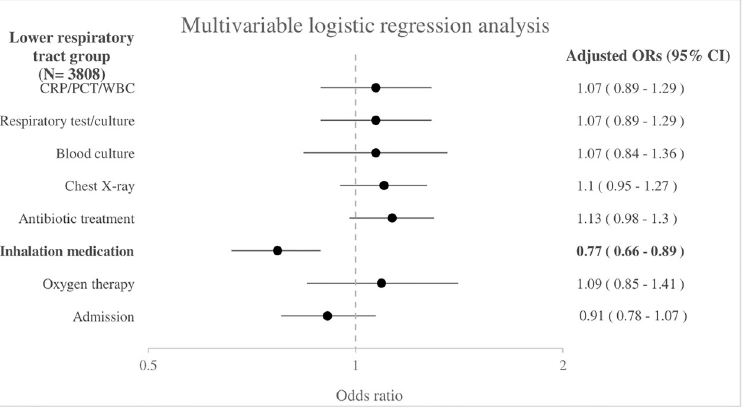
Fig 3. Association between sex and management in the lower respiratory tract group (N = 3808). Boys as reference group. Adjusted for age, triage urgency, ill appearance, tachypnea, tachycardia, hypoxia, work of breathing, duration of fever,